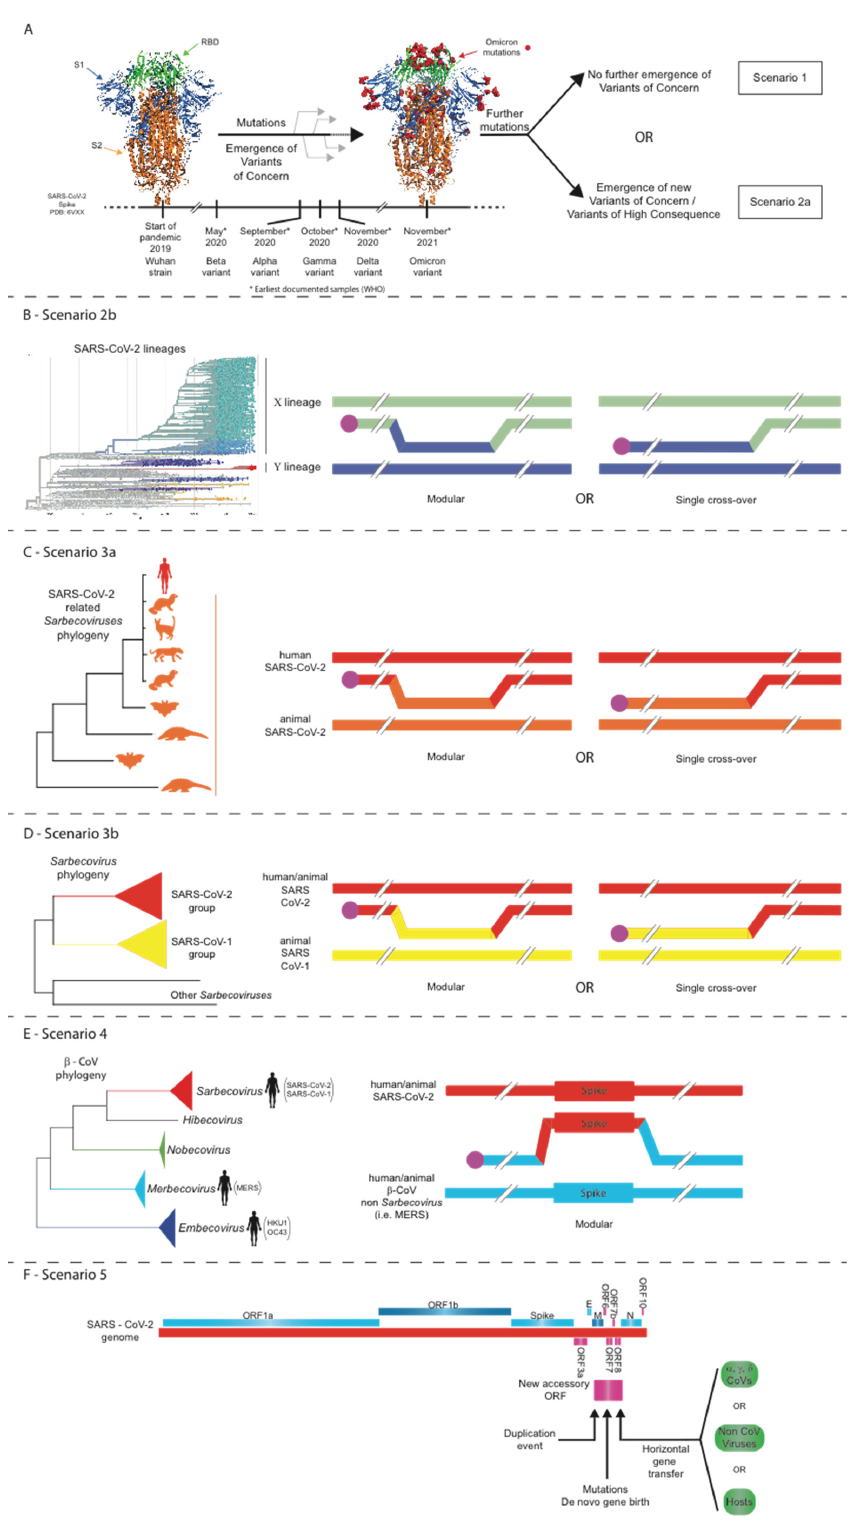
Figure 1. Five scenarios for the future evolutionary trajectory of SARS-CoV-2. ( A ) Scenario 1: struc- tural constraints limit any further evolution of the SARS-CoV-2 spike; Scenario 2a: point